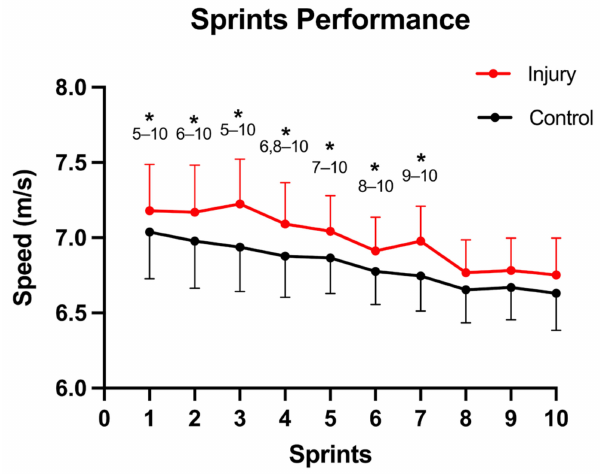
Figure 2. Acute effects of a sprint protocol on the average maximal speed injured players vs. healthy controls. Data are presented as mean ± standard deviation. * Significant difference between the current sprint and each subsequent sprint